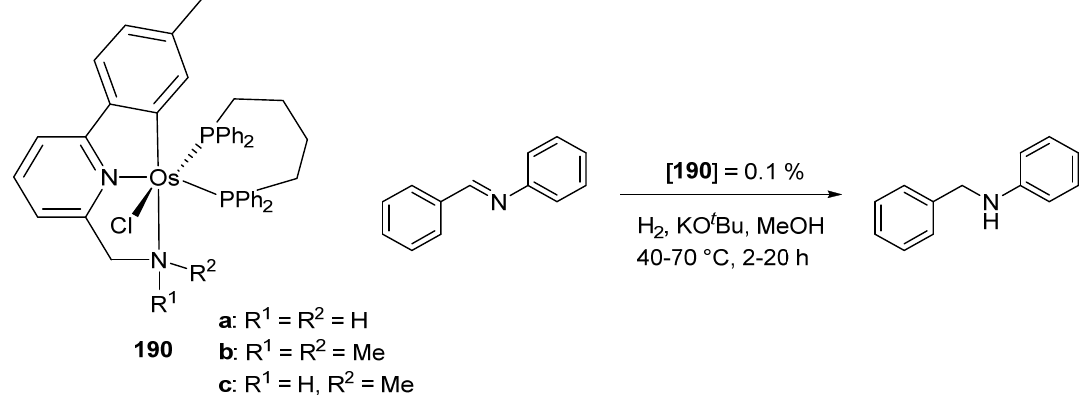
Figure 43. Hydrogenation of imines catalyzed by C~N~N pincer complexes.